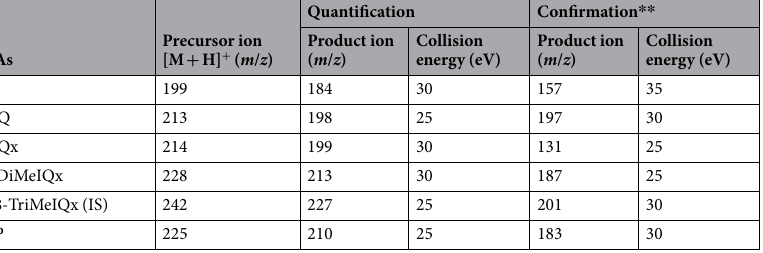
Table 4. SRM parameters applied with MS/MS technique * . * Dwell time (25 ms) in all HCAs; ** confirmation ion intensity was > 10%; IS = Internal